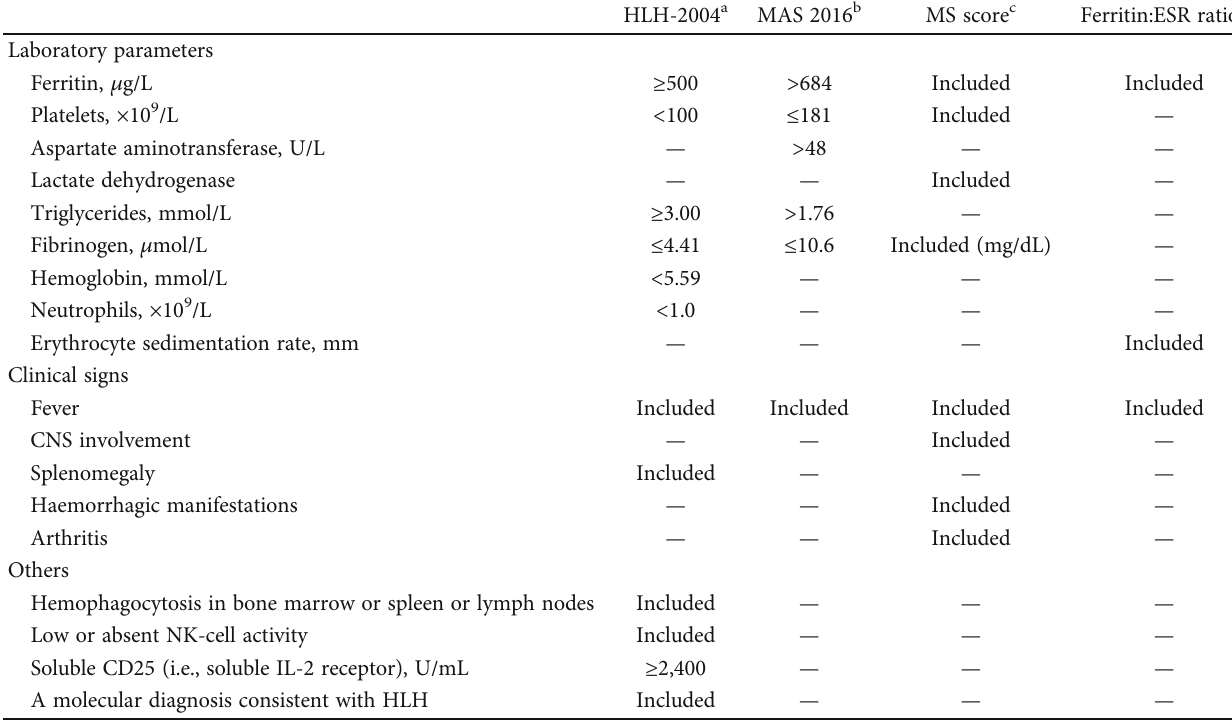
Table 1: Comparison of HLH-2004 diagnostic guidelines, MAS 2016 classi fi cation criteria, MS score, and ferritin to erythrocyte sedimentation rate ratio for the diagnosis of MAS.